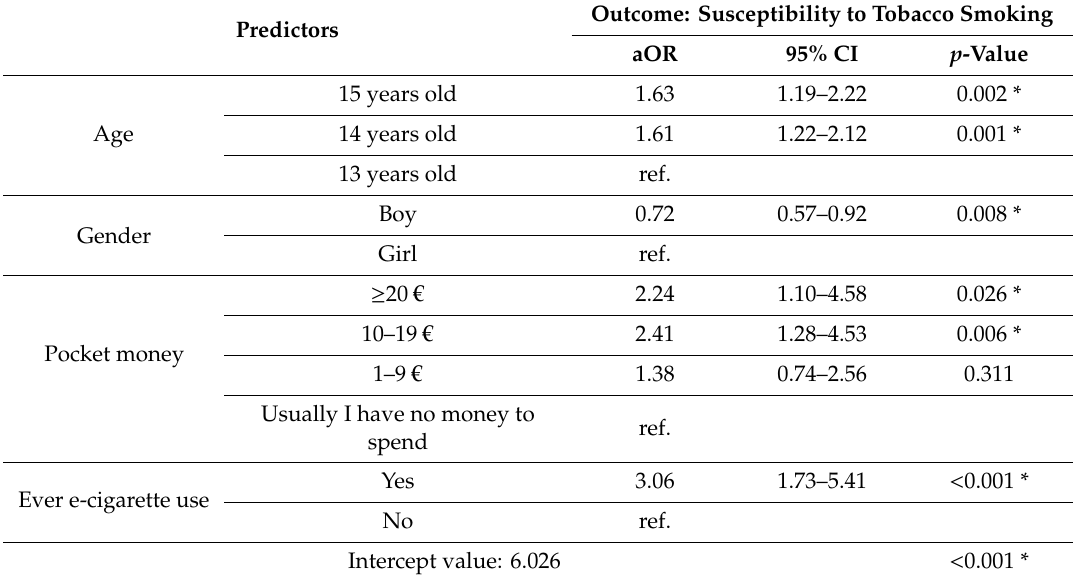
Table 6. Multivariable analysis of susceptibility to tobacco smoking among never